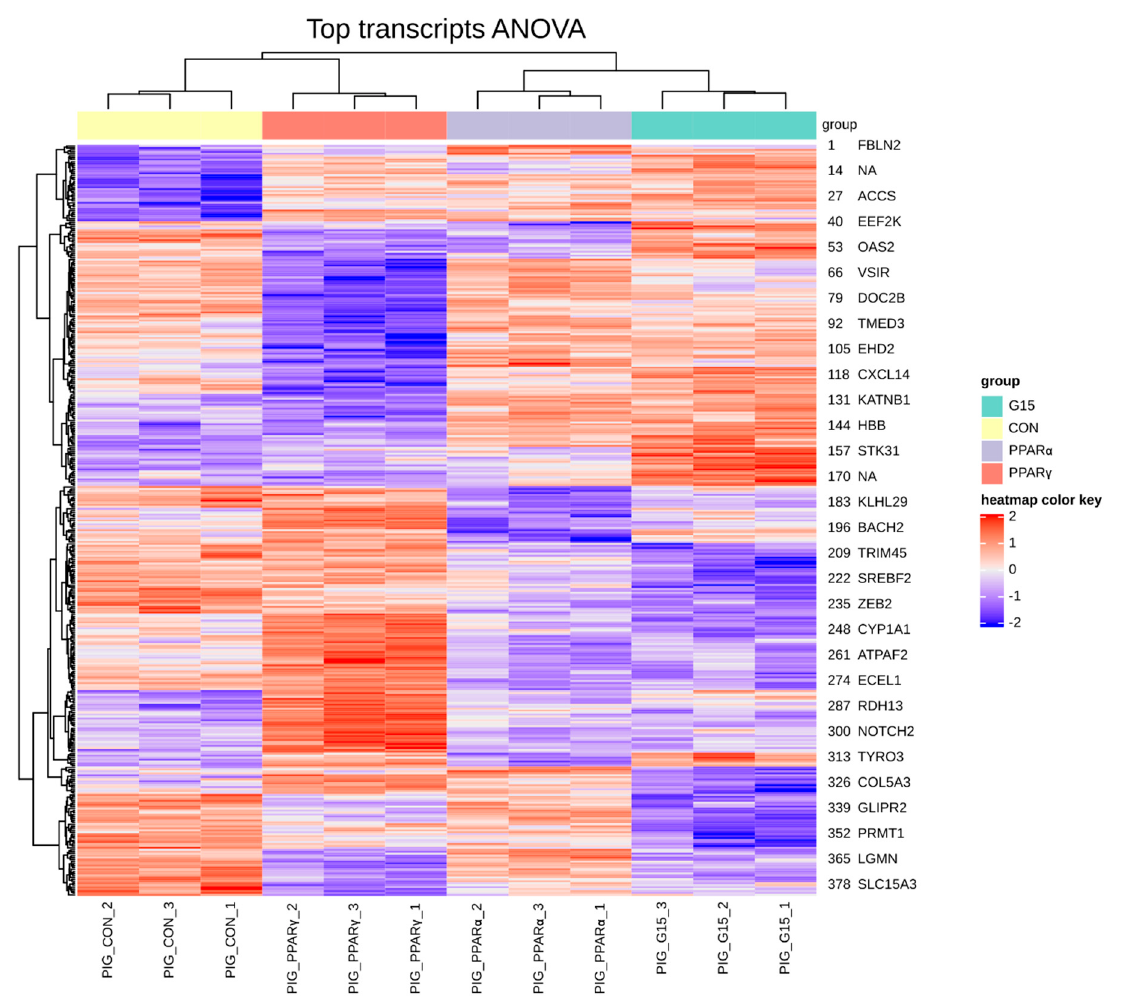
Figure 1. Hierarchical clustering and heatmap of expression profiles for samples and genes (383) with altered expression. Global ANOVA test across PPAR α , PPAR γ and GPER antagonist-treated groups. (PIG_CON—control group, PIG_PPAR α – group treated with PPAR α antagonist, PIG_PPAR γ —group treated with PPAR γ antagonist, PIG_G15group treated with G15